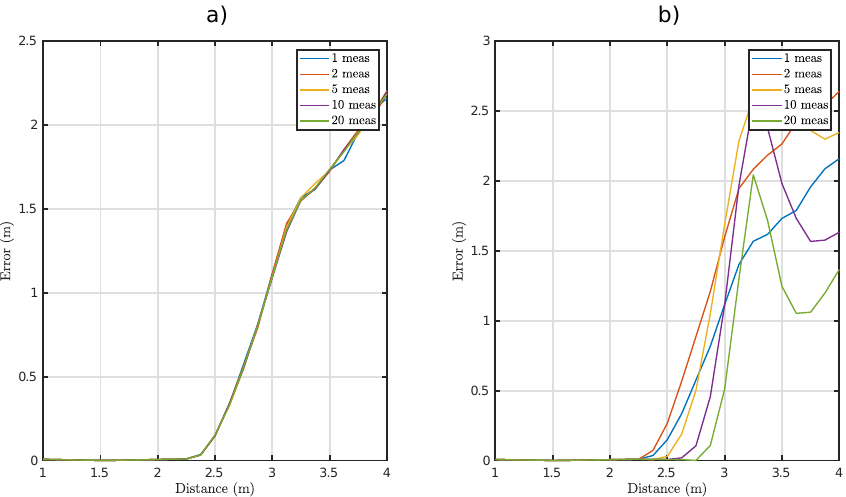
Figure 12. Expected error versus distance for different number of runs: ( a ) the typical averaging strategy; and ( b ) the proposed mode-based